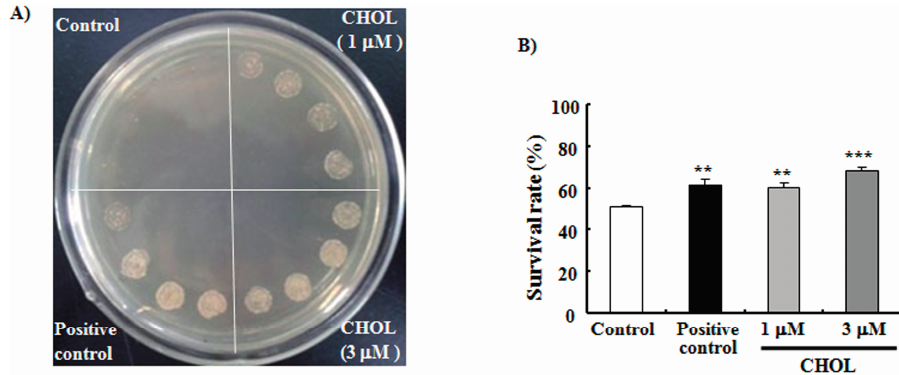
Figure 2. Effects of CHOL on the oxidative resistance of yeast. ( A ) BY4741 yeast was incubated for 12 h after treatment with 0, 1, or 3 μ M CHOL. Cell culture solutions (5 μ L) with the same OD were dropped onto plates containing 9 mM H 2 O 2 . The plates were incubated for 4 days at 28 °C and subsequently photographed. Positive control: 10 μ M phloridzin; ( B ) BY4741 yeast cells were spread on glucose agar plates with or without 4 mM H 2 O 2 . The plates were then incubated for 2 days at 28 °C. Each experiment was conducted at least three times. Vertical bars represent the mean SEM of three assays. ** p < 0.01 and *** p < 0.001 indicates statistically significant